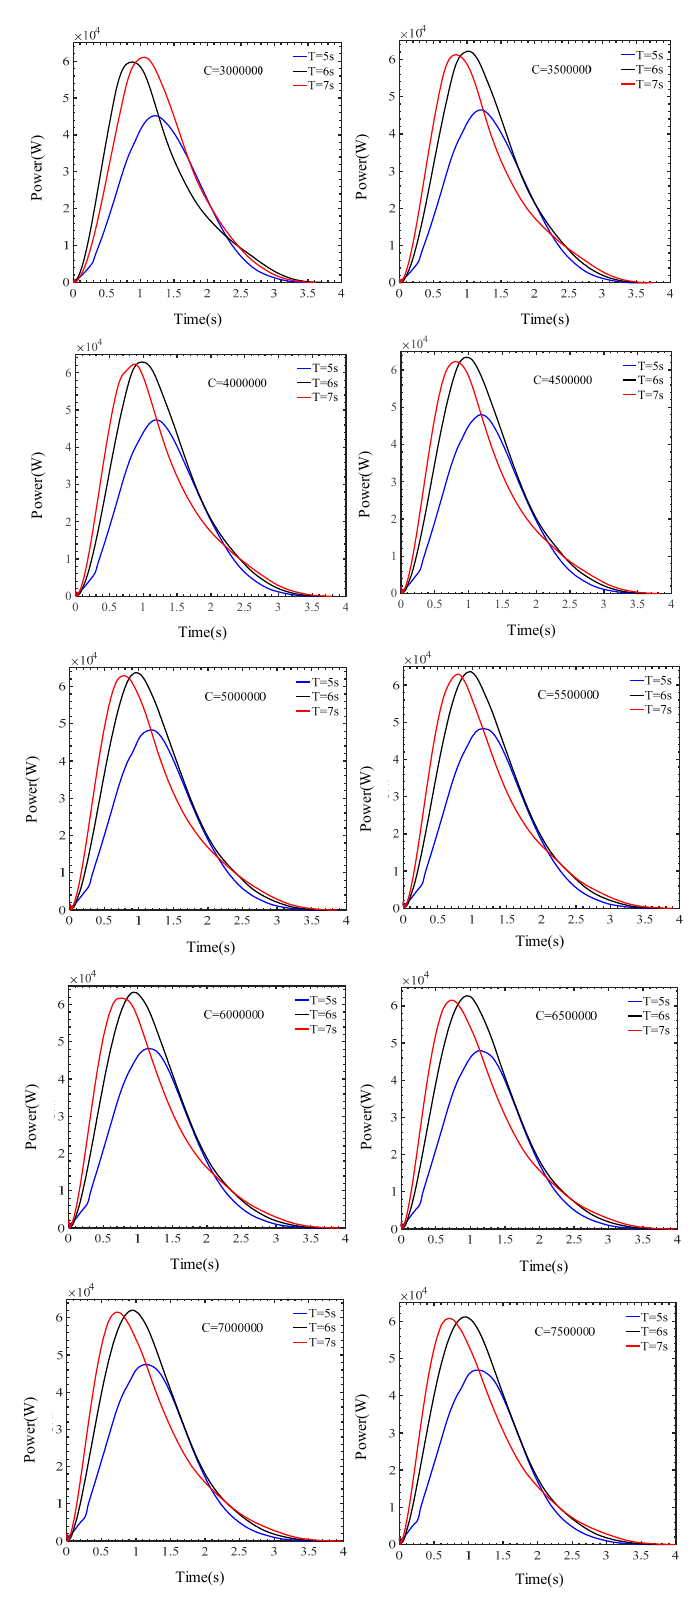
Figure 5. Power curves at different linear moment coefficient. Therefore, there were optimal damping coefficients for different wave periods. For wave periods T = 5 s, T = 6 s and T = 7 s the effective power reached the maximum when the damping coefficient was 5,000,000 N ∙ m ∙ s ∙ rad (cid:2879)(cid:2869) , 450,000 N ∙ m ∙ s ∙ rad (cid:2879)(cid:2869) and 5,500,000 N ∙ m ∙ s ∙ rad (cid:2879)(cid:2869) , respectively, as shown in Figure 6. The maximum effective